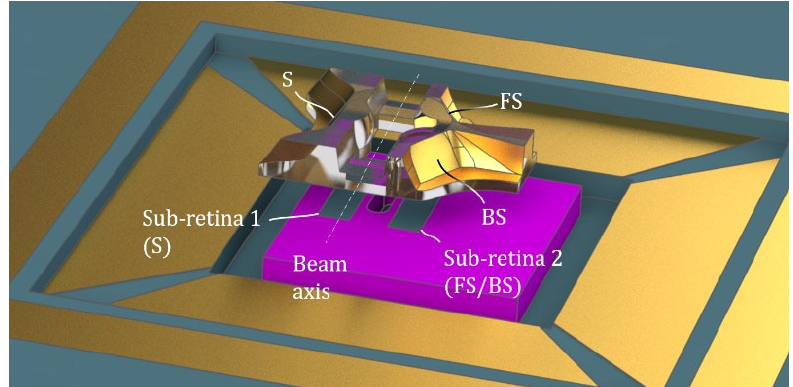
Figure 8. 3D view of the monolithic optical system aligned with the holed retina.